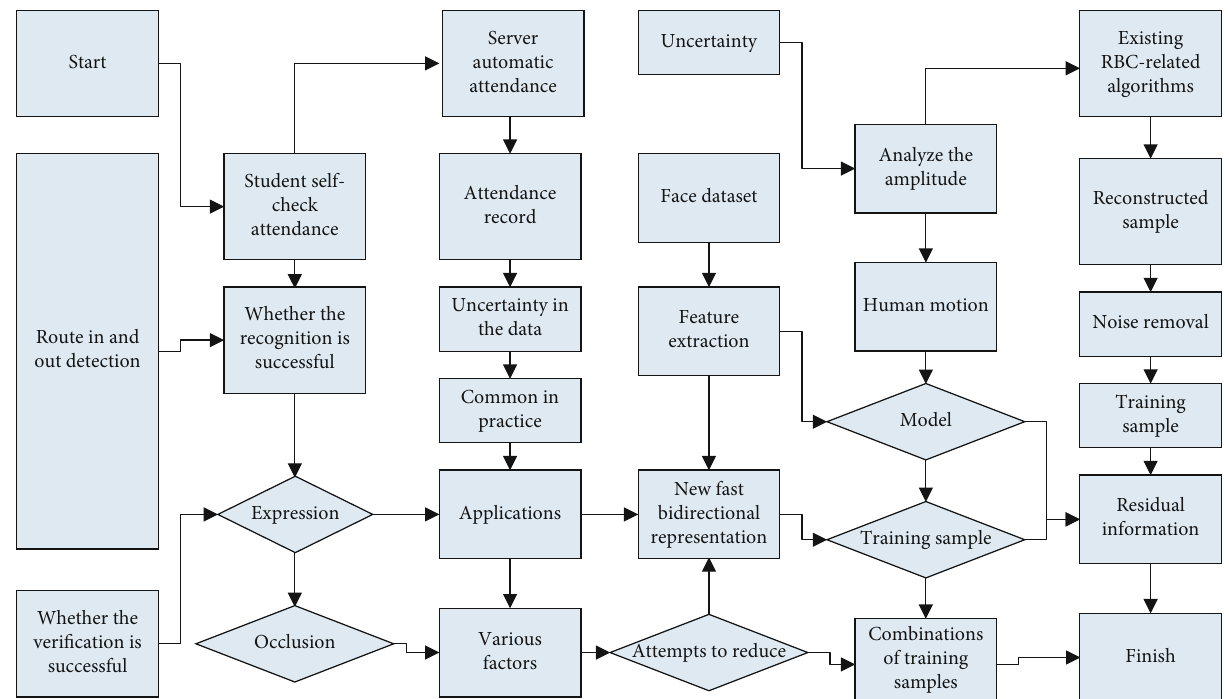
Figure 4: Student attendance fl ow chart.